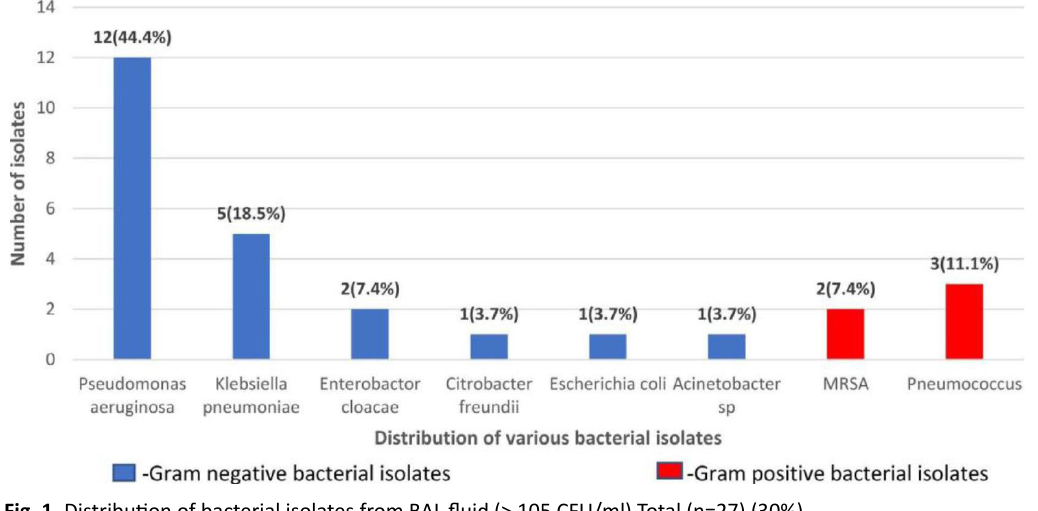
Fig. 1. Distribution of bacterial isolates from BAL fluid (> 105 CFU/ml) Total (n=27)